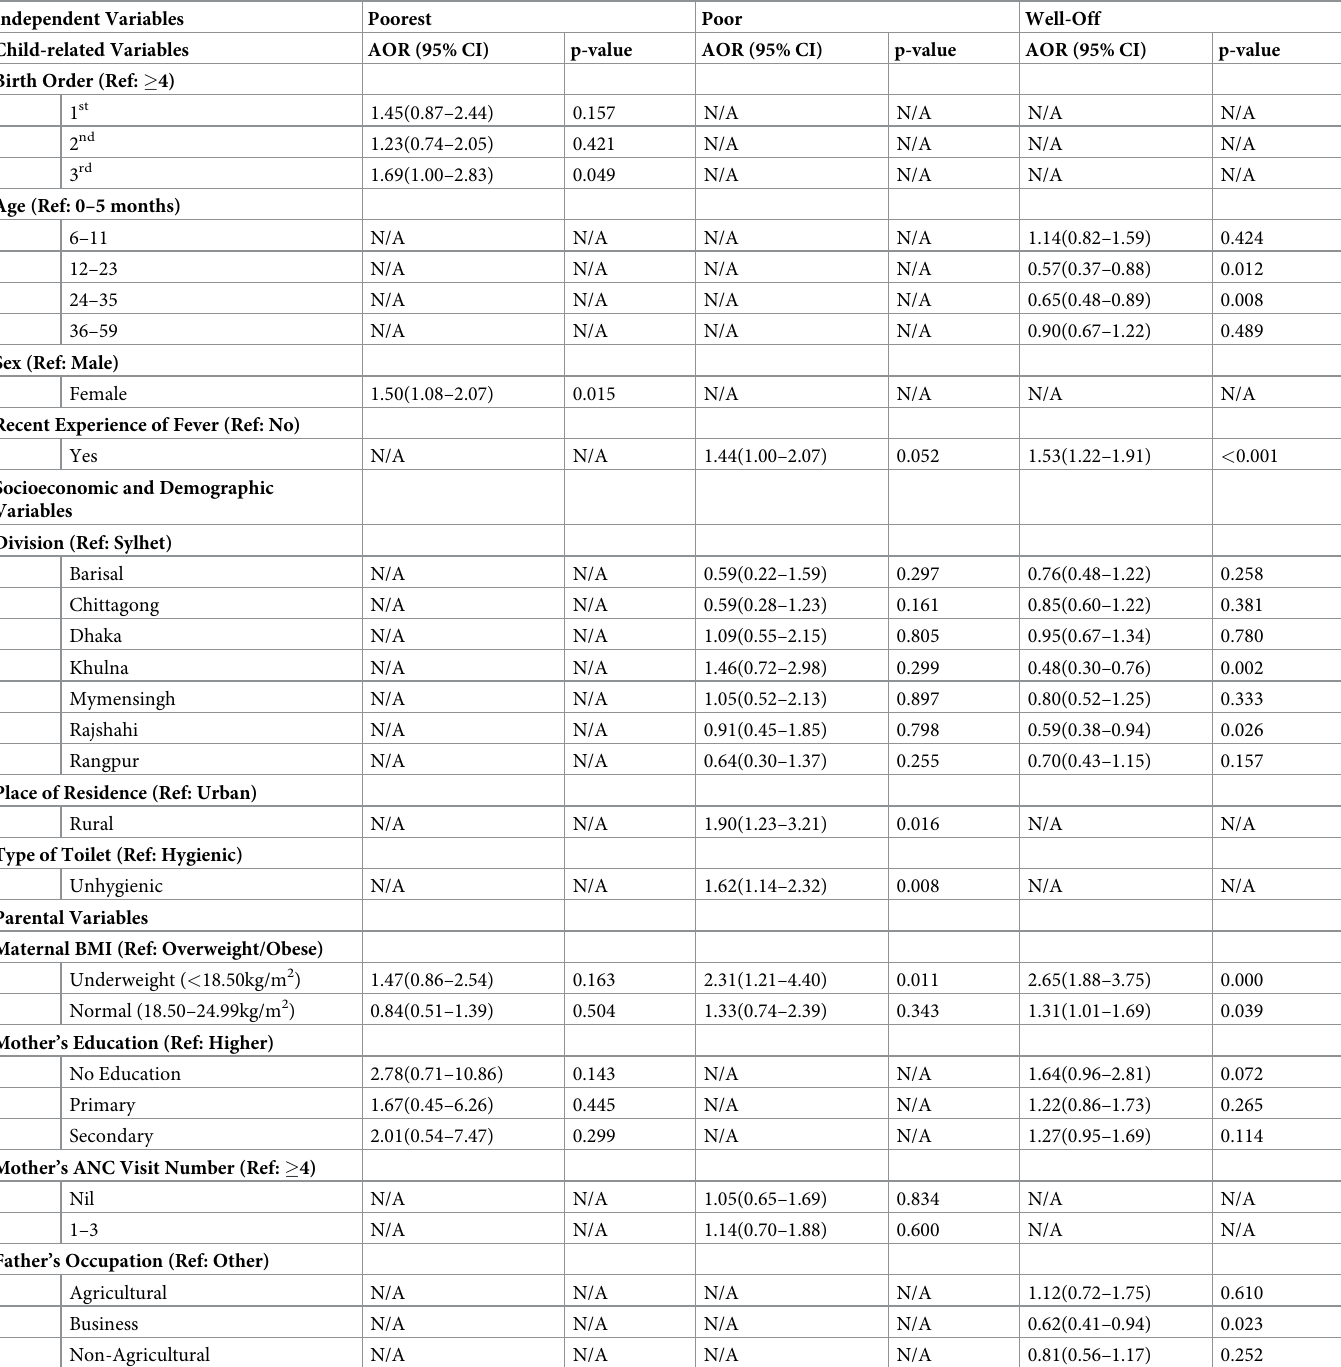
Table 5. Factors associated with wasting within different categories of wealth